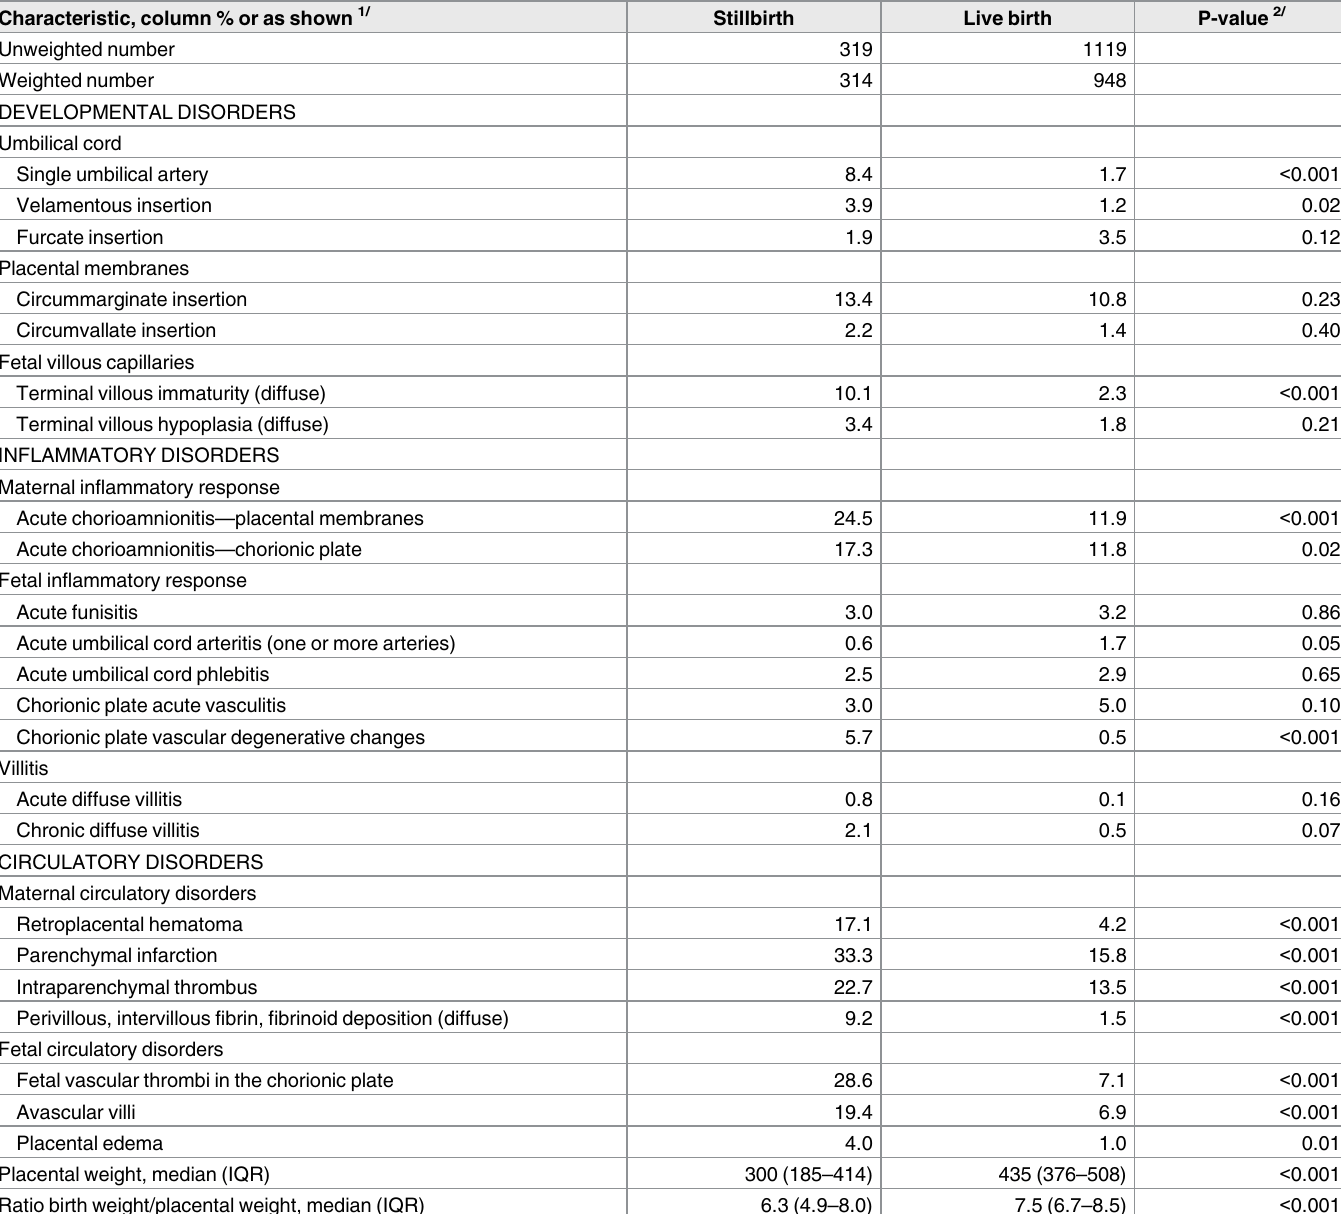
Table 3. Placental findings in singleton stillbirths and live births (cid:21) 24 weeks GA. Characteristic, column % or as shown